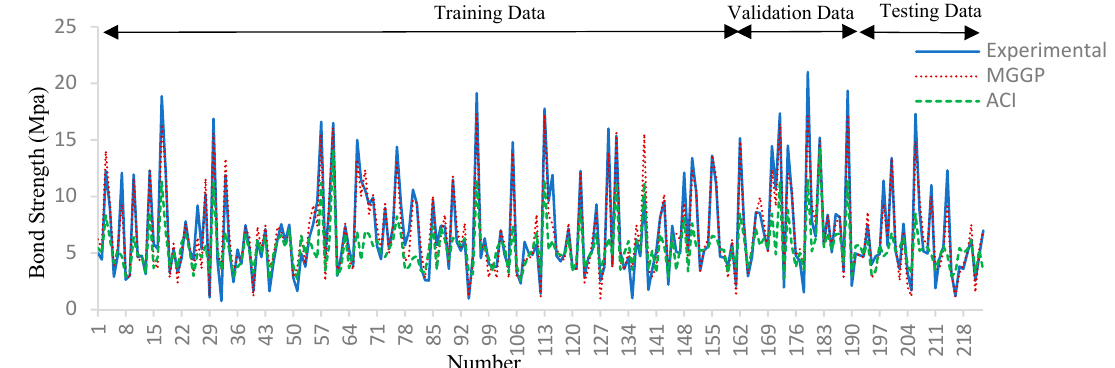
Figure 7. Bond strength predictions using the MGGP and ACI models.